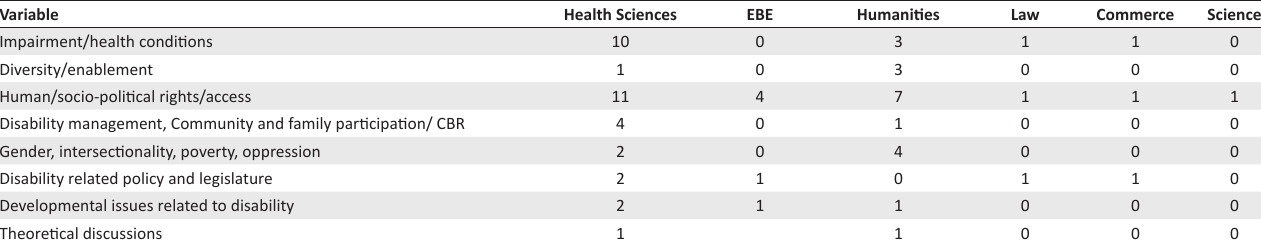
TABLE 3: Focus of inclusion. Variable